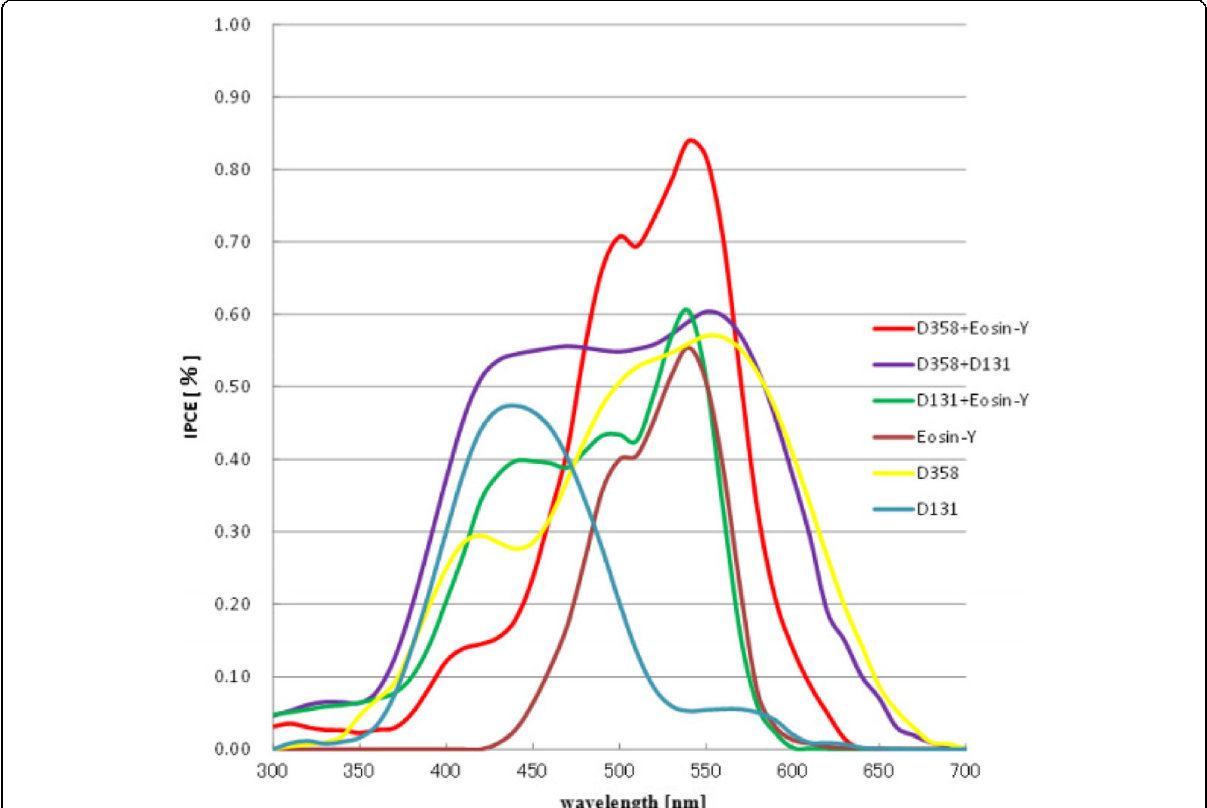
Fig. 24 IPCE of mixed pigment and single pigments, where single pigment were Eosin Y, D131, and D358 and mixed pigments were D358 and Eosin Y; D358 and D131; D131 and Eosin Y [311]